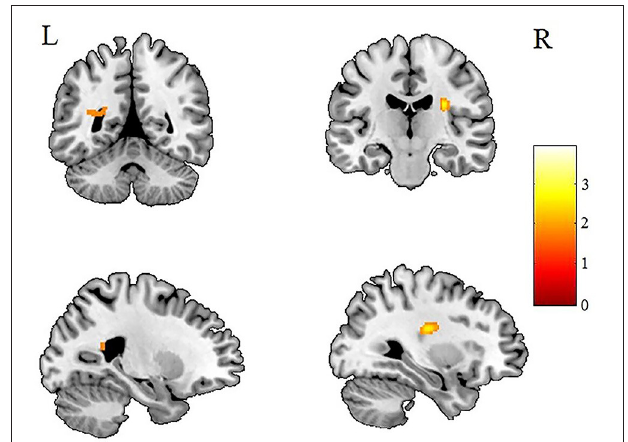
FIGURE 3 | Patients with IGE showed increased AD (refer to color scale) in the WM of the left occipital lobe and the right corona radiata compared with healthy controls after AlphaSim correction ( P < 0.05). AD, axial diffusivity; WM, white matter.